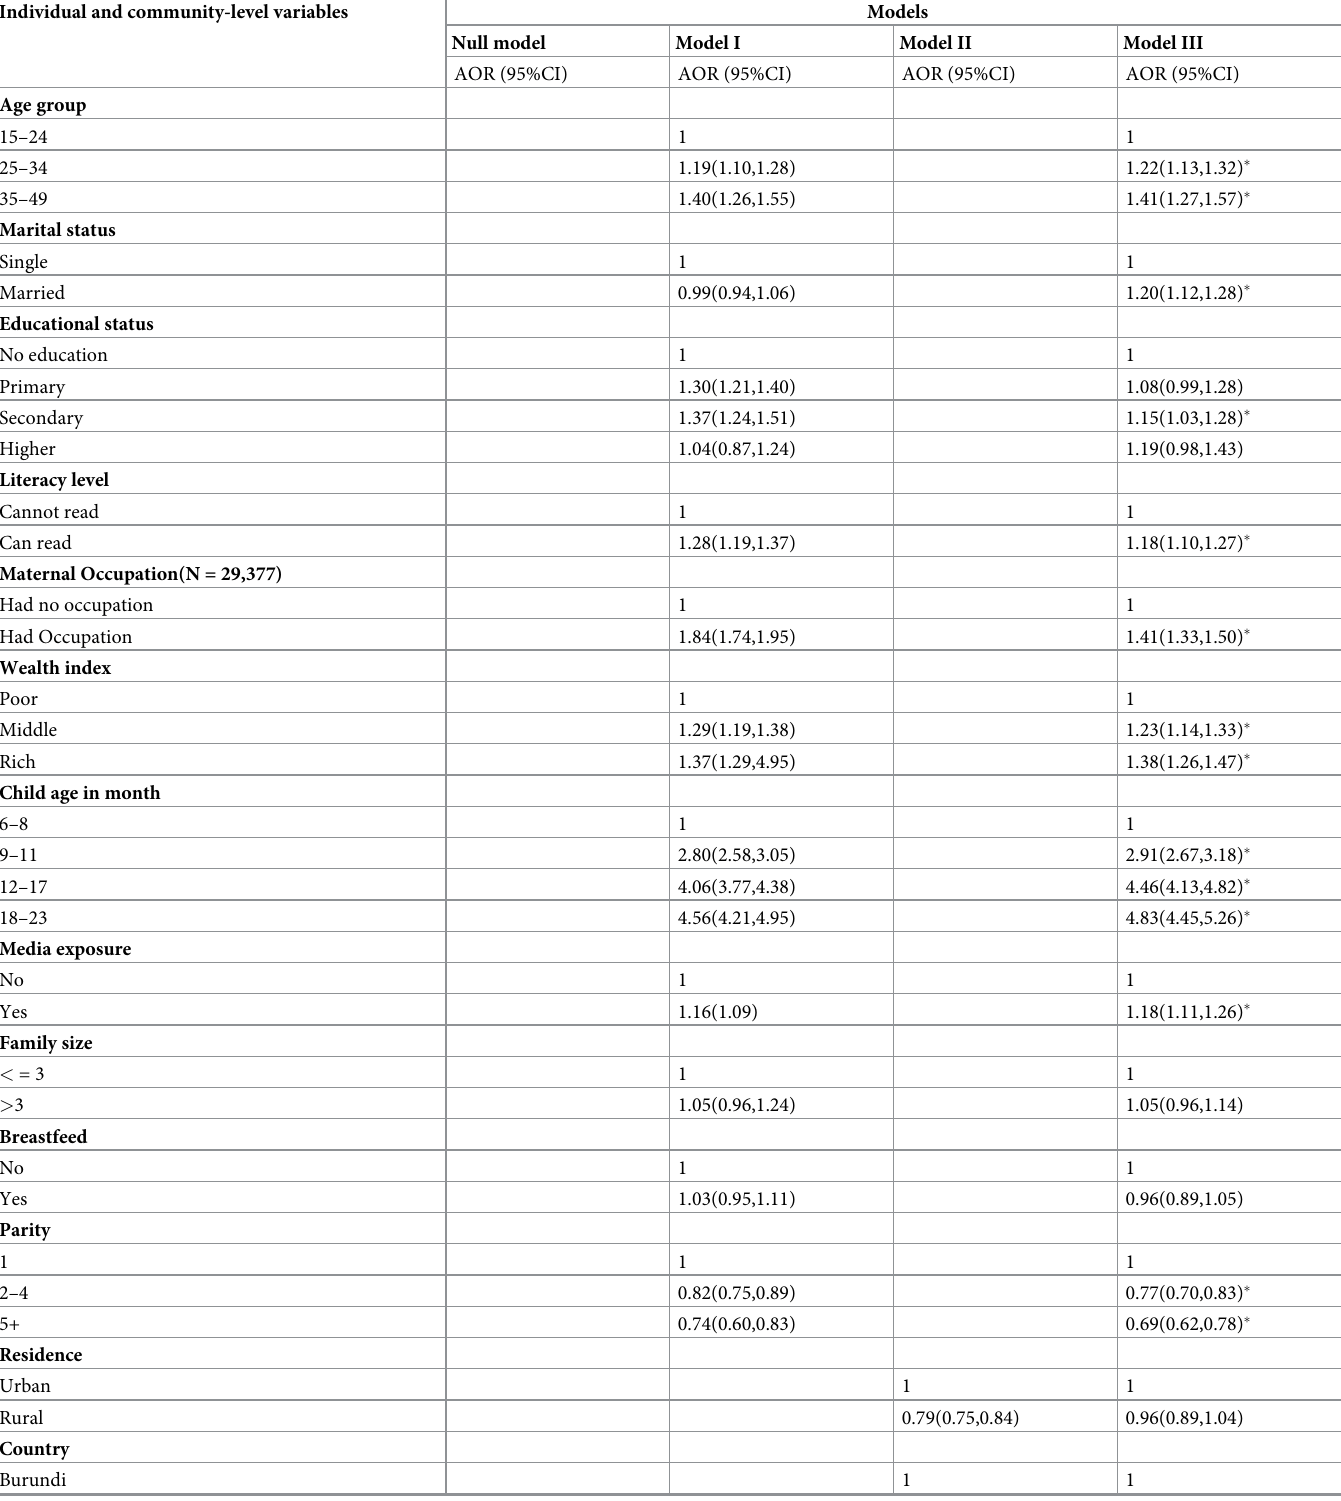
Table 2. Multivariable multilevel logistic regression analysis of both individual and community-level factors associated with vitamin A consumption in East Africa Countries from 2008 to